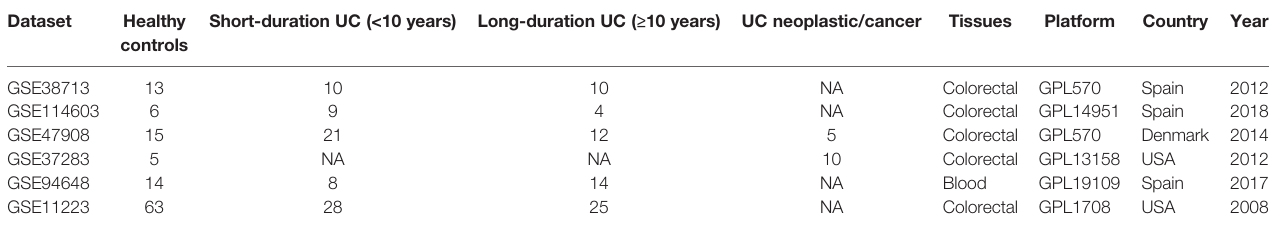
TABLE 1 | Characteristics of studies composing the dataset gene expression.